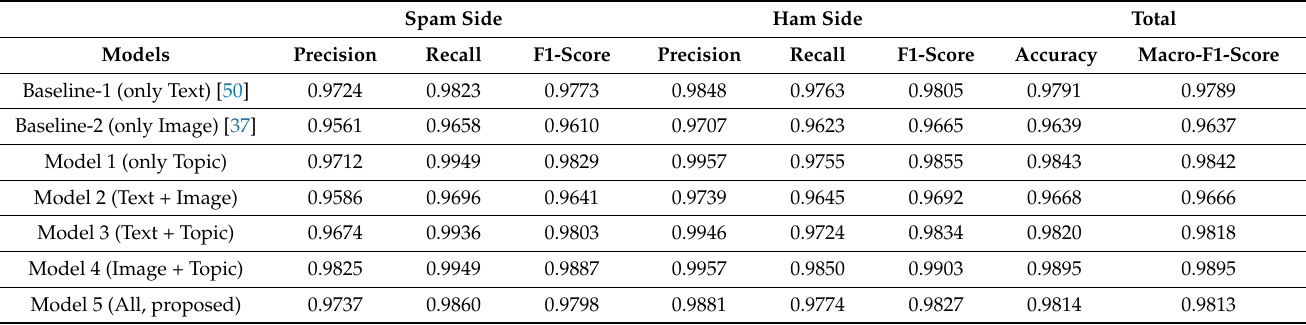
Table 10. Features and performance indicators of the models